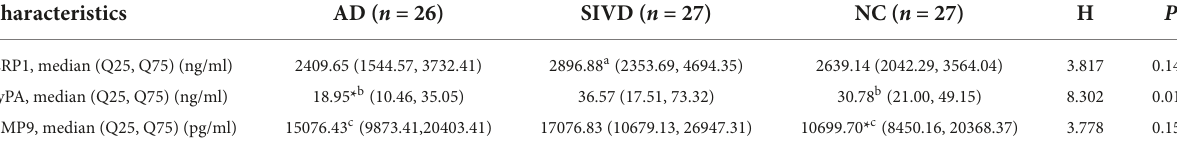
TABLE 2 sLRP1, CyPA, and MMP9 values by diagnostic groups. Characteristics